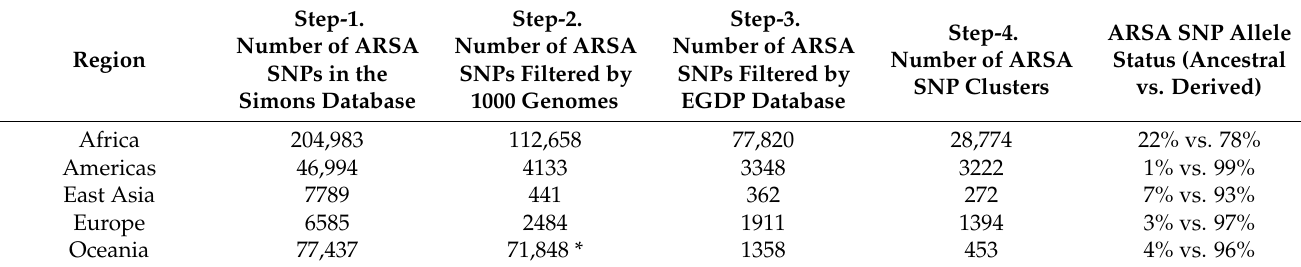
Table 1. Numbers of ARSA SNPs in five remote geographical